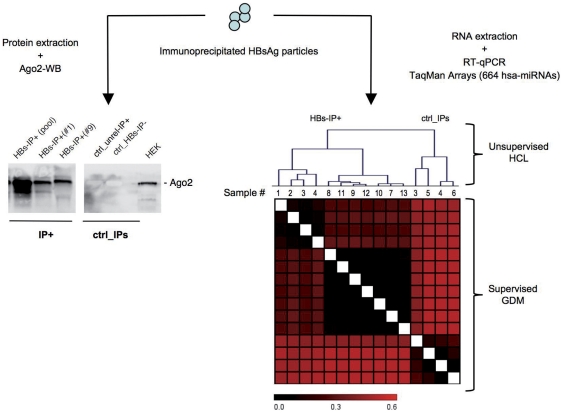
Differences in Western Blotting and human miRNA analyses between immunoprecipitated HBsAg particles and control immunoprecipitations.Left-most: Western blotting analysis of protein lysates from HBsAg positive immunoprecipitates (HBs-IP+) and control HBsAg negative immunoprecipitates (ctrl-IPs) for detection of Ago2 protein. IP+ lanes contain pooled protein lysates from samples # 1–13 and single lysates from samples # 1 and 9 respectively. Ctrl-IPs lanes contain protein lysates from immunoprecipitates obtained from HBsAg positive sera with mouse monoclonal anti-human c-myc antibody (unrelated-IP+) and HBsAg negative sera using anti-HBs monoclonal antibody (HBs-IP−). HEK is the protein lysate from HEK cells used as positive control for Ago2 protein. The figure is representative of 3 independent experiments. Right-most: HCL is unsupervised hierarchical cluster analysis of detected miRNAs (DCT values) in both HBs-immunoprecipitated fractions from HBsAg positive immunoprecipitates (HBs-IP+) and control HBsAg negative immunoprecipitates (ctrl-IPs). GDM is supervised gene distance matrix correlating DCt values of HBs-IP+ vs ctrl-IP samples.